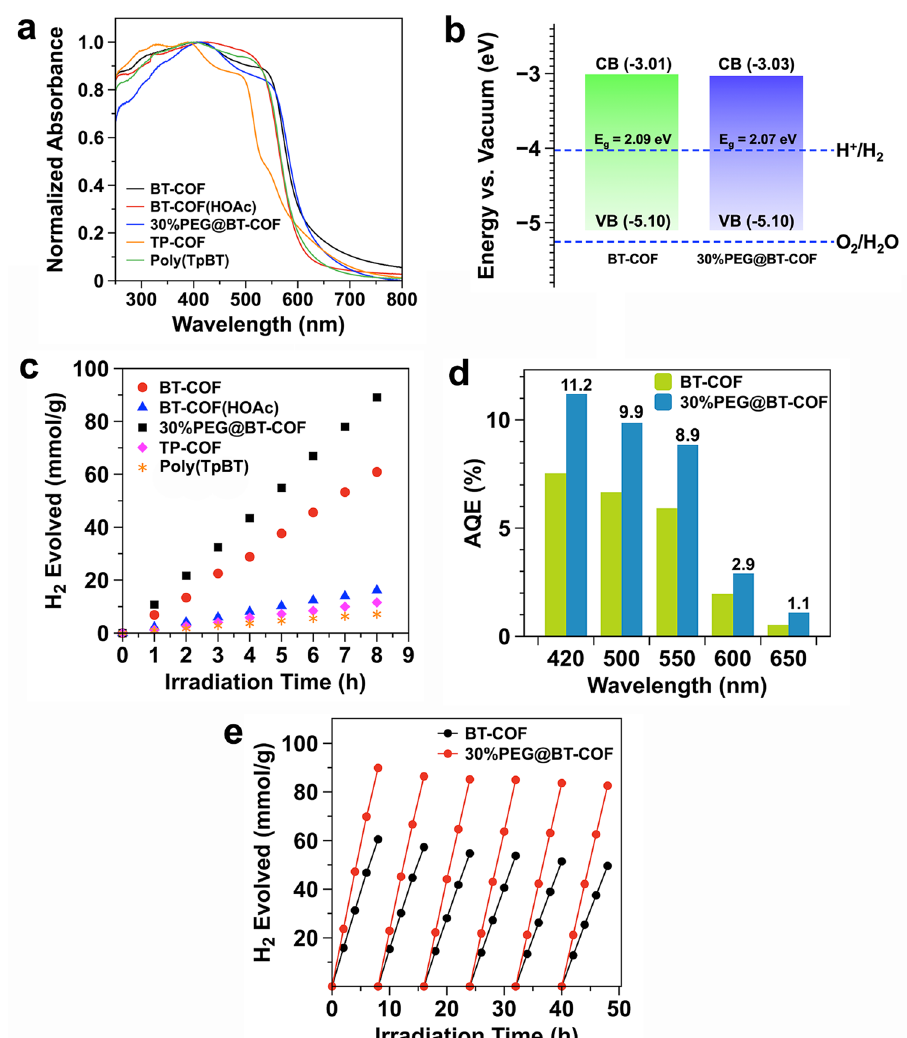
Fig. 3 Absorption spectra, band structure, and photocatalytic H 2 evolution. a UV − vis diffuse re fl ectance spectra of poly(TpBT), BT-COF, BT-COF (HOAc), 30%PEG@BT-COF, and TP-COF measured in solid state. b Energy band structures of BT-COF and 30%PEG@BT-COF determined by synchrotron radiation photoemission spectroscopy. c Time course for photocatalytic H 2 production under visible irradiation for BT-COF, BT-COF(HOAc), 30% PEG@BT-COF, poly(TpBT), and TP-COF, respectively. d Apparent quantum ef fi ciency of BT-COF and 30%PEG@BT-COF at fi ve different incident light wavelengths. e Photocatalytic H 2 production with the BT-COF and 30%PEG@BT-COF, respectively, upon 48-h illumination of visible